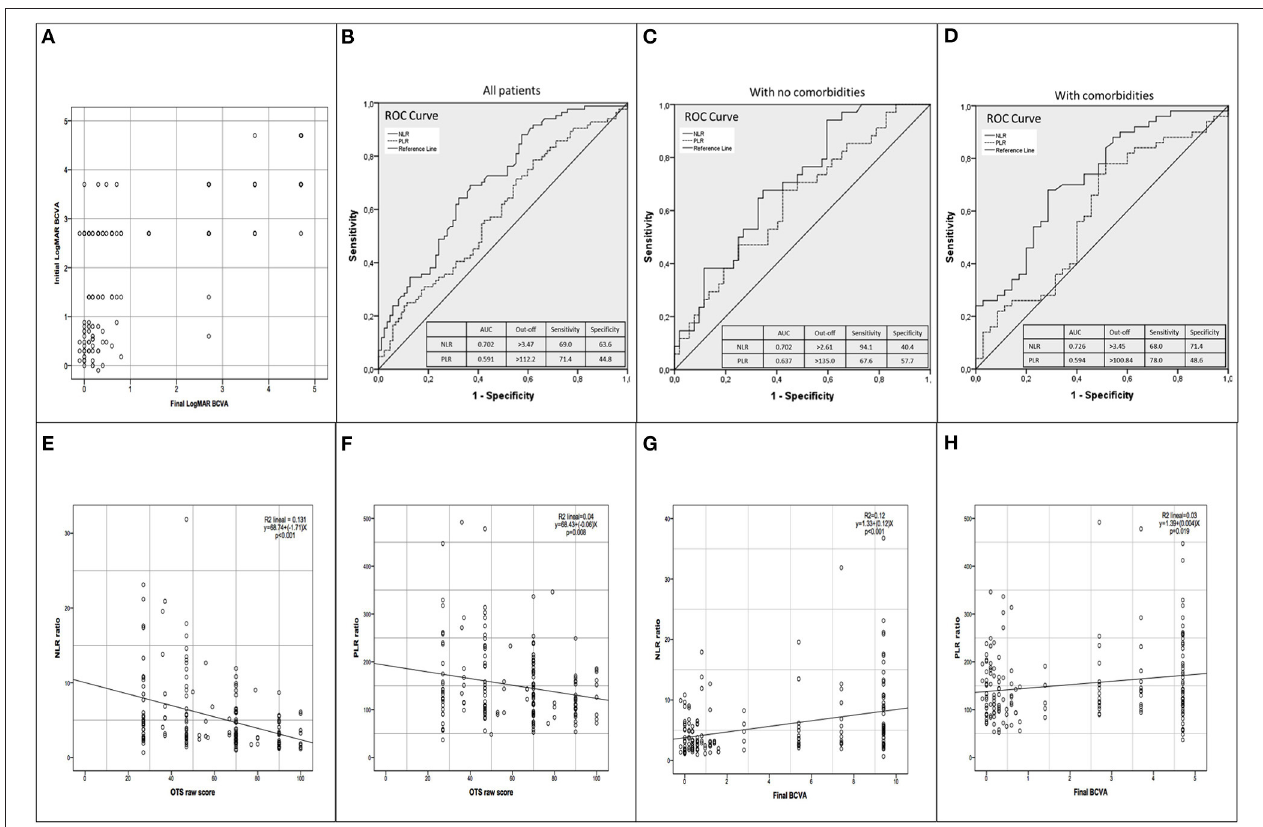
FIGURE 1 | (A) Scatterplot of the initial LogMAR best corrected visual acuity (BCVA) with the final LogMAR BCVA. Patients with better initial BCVA were more likely to have better final BCVA. The majority that ended with severe visual impairment (SVI) had poor initial BCVA (LogMAR > 2.00 equivalent to count fingers or worst). Only 2 patients with initial BCVA better than count fingers ended with SVI. (B) Receiver Operating Characteristics (ROC) curve analysis for discrimination between patients with SVI and Non-SVI (NSVI) in all patients. (C) ROC curve analysis for discrimination between patients with SVI and NSVI only in patients with no comorbidities. (D) ROC curve analysis for discrimination between patients with SVI and NSVI only in patients with comorbidities. (E) Scatterplot and linear regression of neutrophil to lymphocyte ratio (NLR) with the ocular trauma score (OTS) raw points. (F) Scatterplot and linear regression of platelet to lymphocyte ratio (PLR) with the OTS raw points. (G) Scatterplot and linear regression of NLR with the final BCVA. (H) Scatterplot and linear regression of PLR with the final